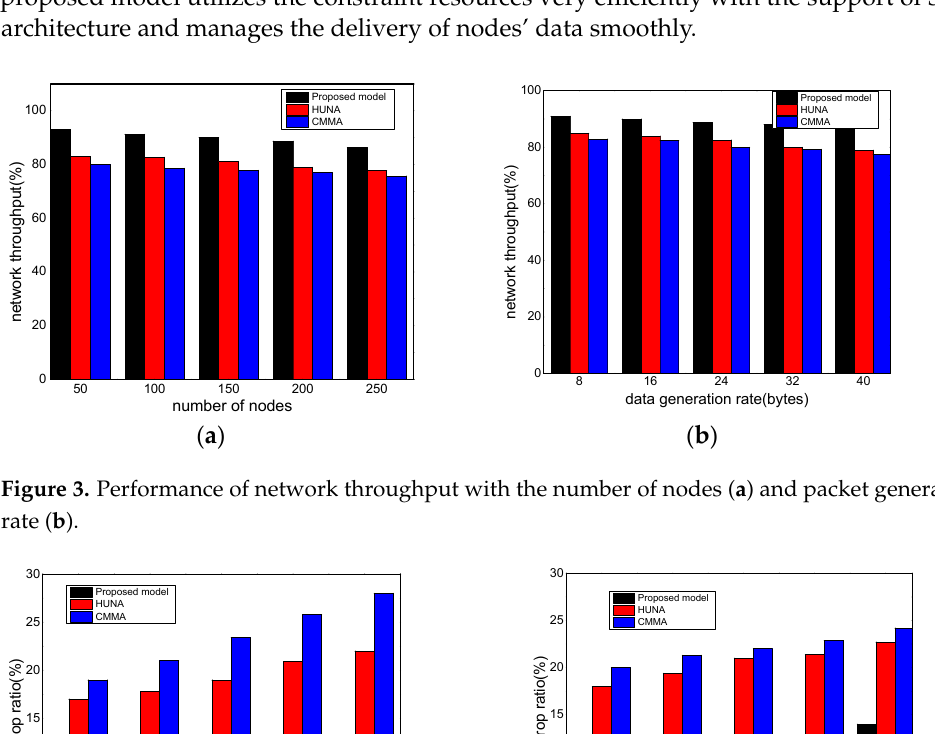
Figure 3. Performance of network throughput with the number of nodes ( a ) and packet generation rate ( b ).